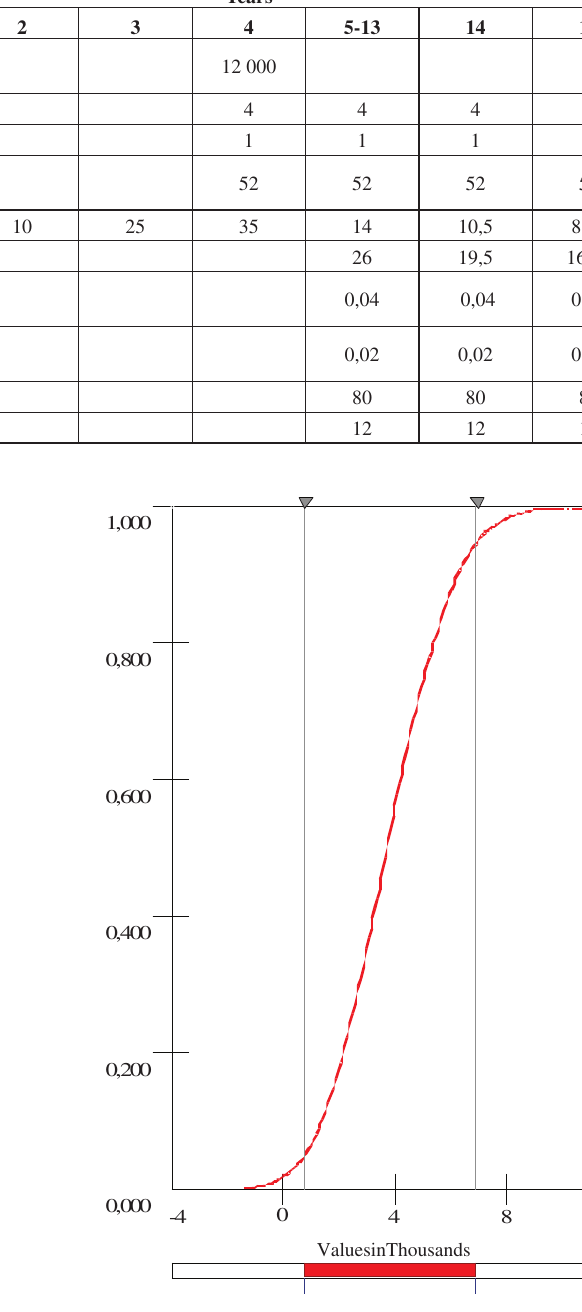
Fig. 5. The distribution function of net present